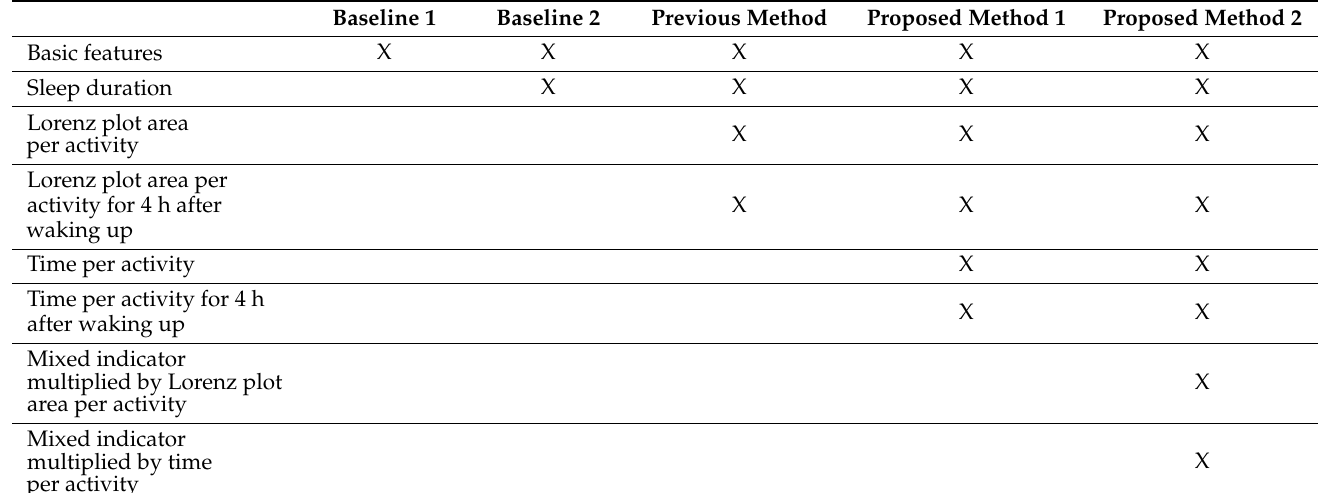
Table 5. Specific features for each